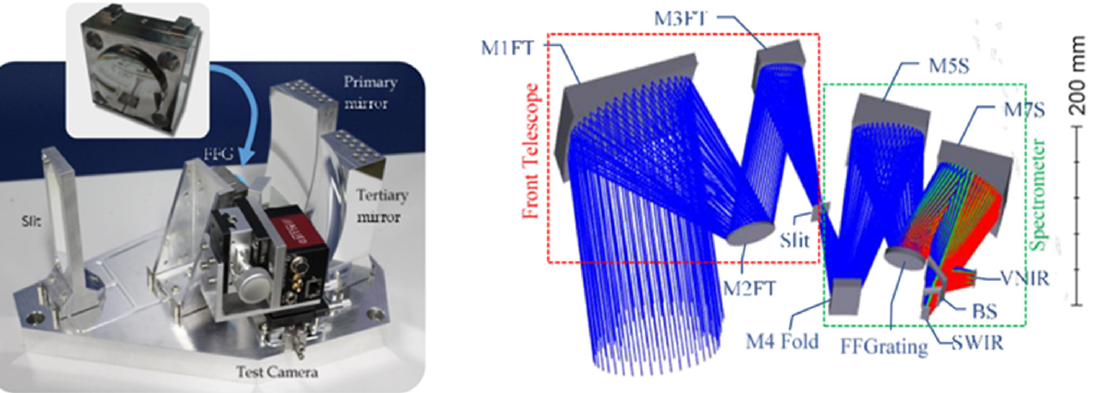
Figure 1. ELOIS spectroscopy instruments. “Reprinted/adapted with permission from Ref. [19]. 2019, Moreau V”.